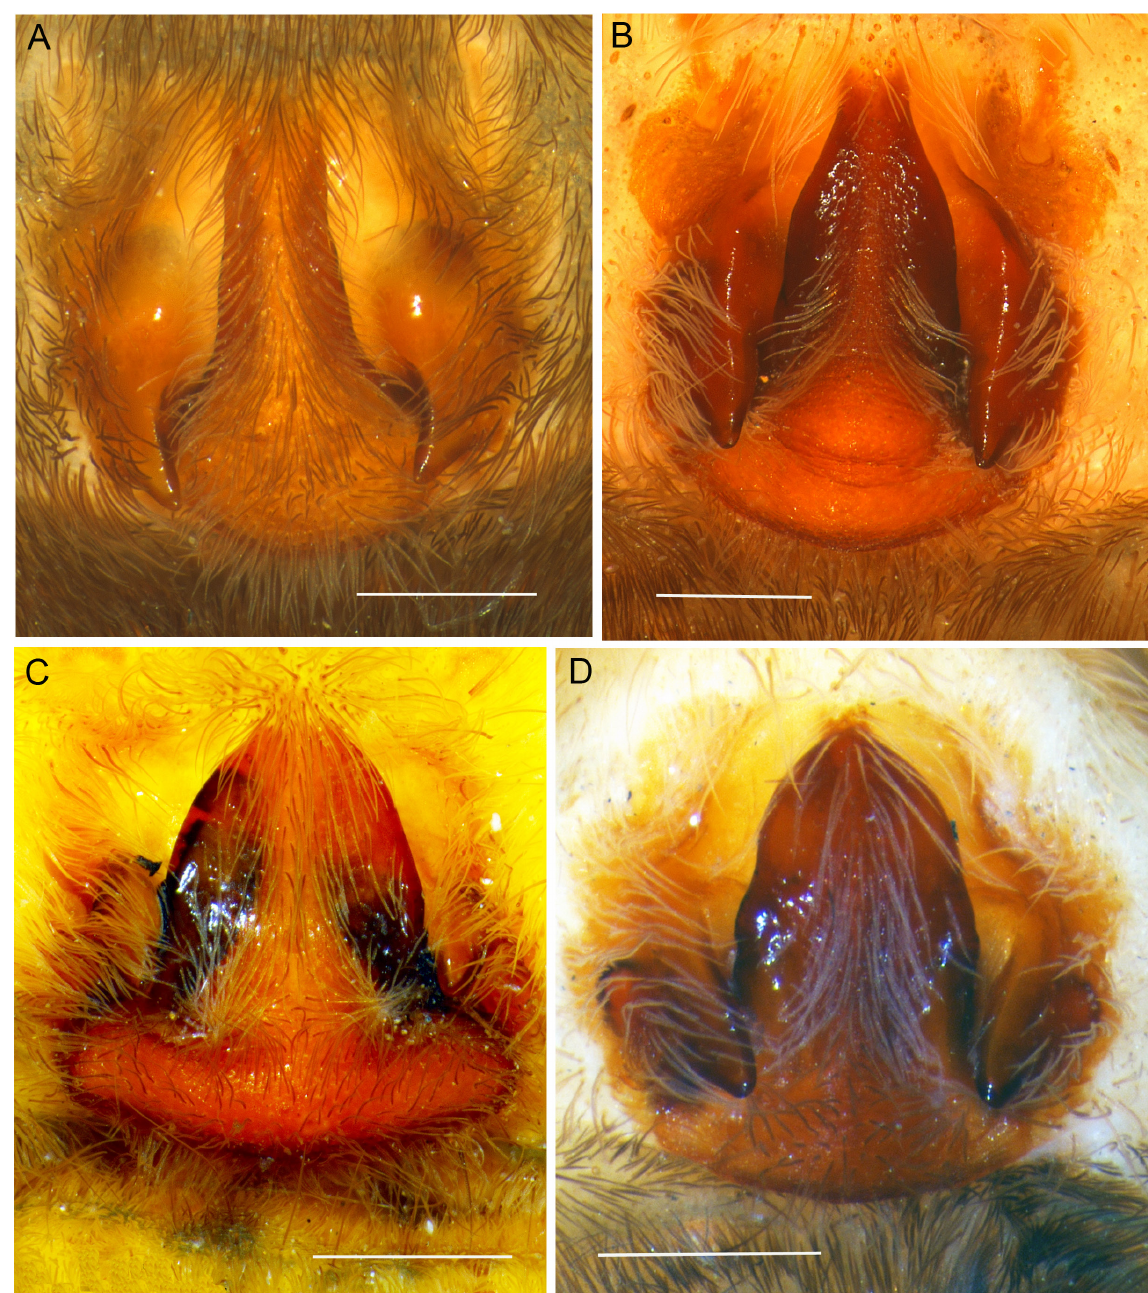
Fig. 12. Epigynum, ventral view. A . Afroneutria immortalis (Arts, 1912) comb. nov. B . Afroneutria quadrimaculata sp. nov. C . Afroneutria erythrochelis (Simon, 1876) comb. nov. D . Afroneutria velox (Blackwall, 1865) comb. nov. Scale bars = 1